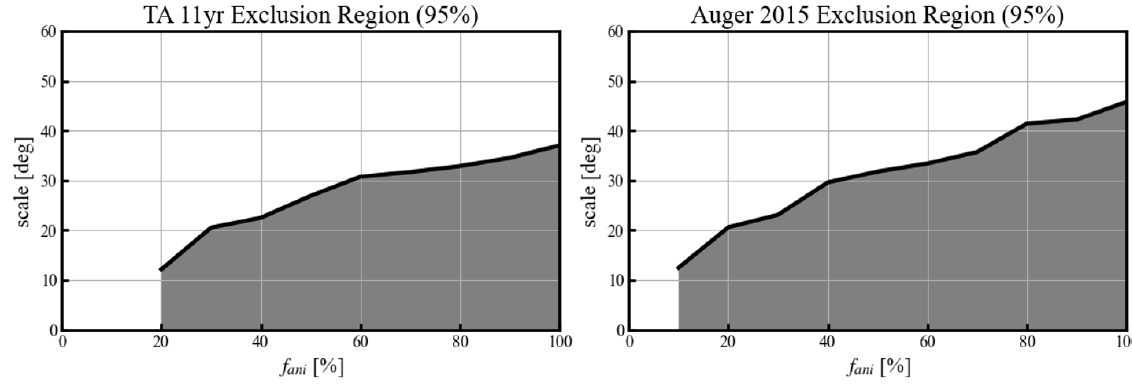
Figure 3. Exclusion area of the TA-11yr dataset (left) and the Auger 2015 dataset (right). The gray areas indicate the exclusion region with 95%